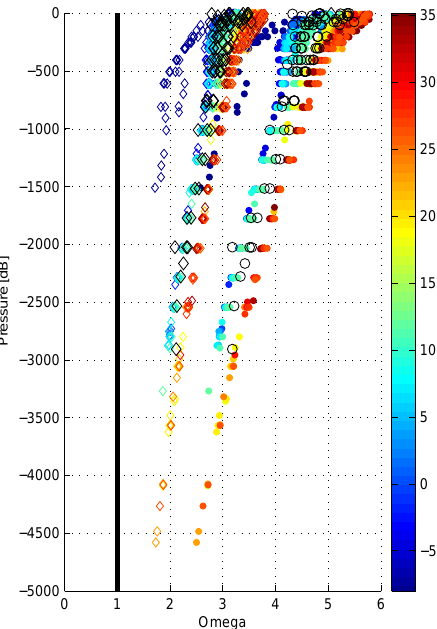
Fig. 9. Vertical distribution of the carbonate saturation state for cal- distribution of the carbonate saturation state for calcite (circles) and aragonite Fig. 9. Vertical cite (circles) and aragonite (diamonds). Data from the EF11 cruise (diamonds). Data from the EF11 cruise are shown as black circles (saturation of calcite) and are shown as black circles (saturation of calcite) and diamonds diamonds (aragonite). The colour code stands for longitude. (aragonite). The colour code stands for